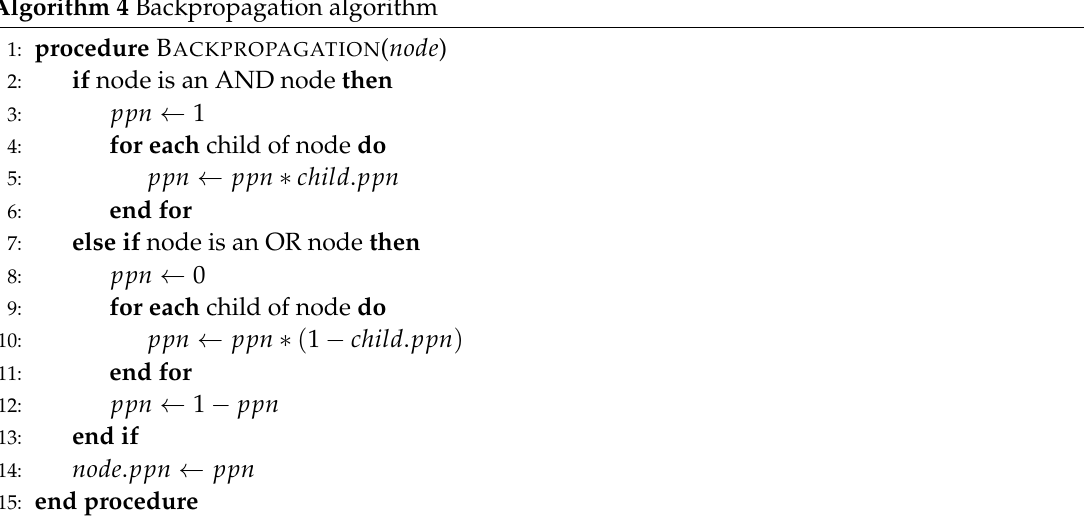
Algorithm 4 Backpropagation